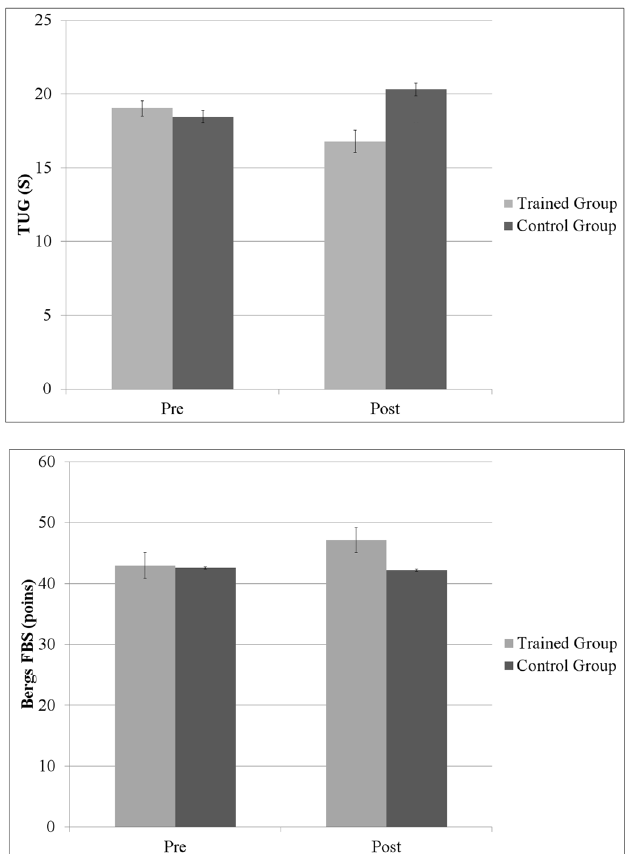
Figure 2. Mean and standard deviation of (A) time taken to complete the TUG and; (B) the score on Berg’s FBS by both groups (control and trained groups); *p=